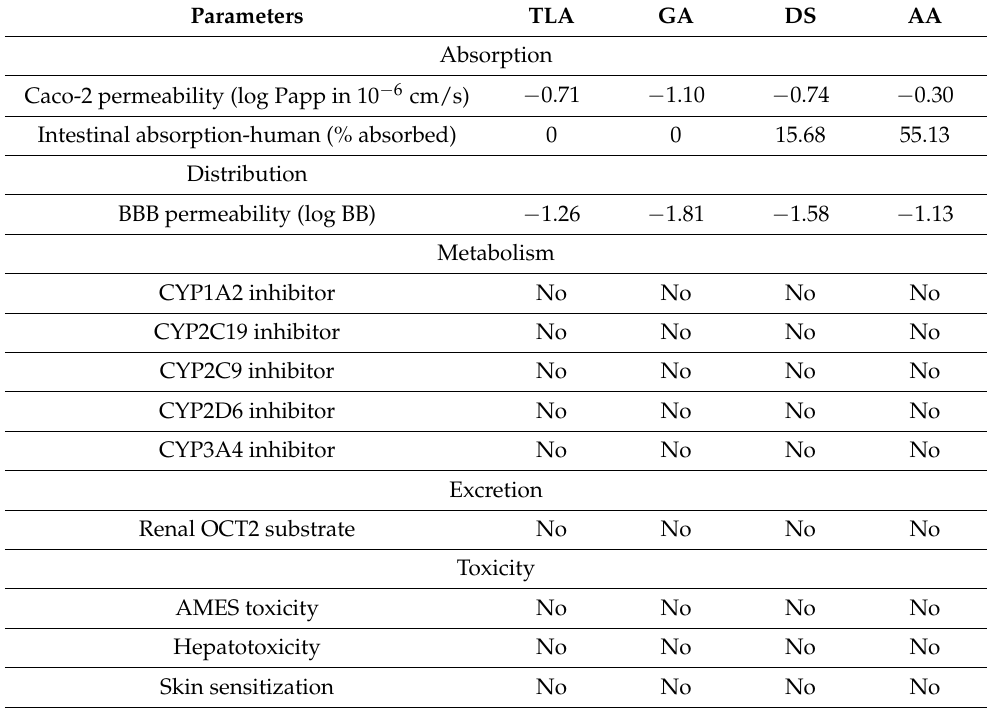
Table 3. Absorption, distribution, metabolism, excretion, and toxicity (ADMET) prediction properties using the pkCSM